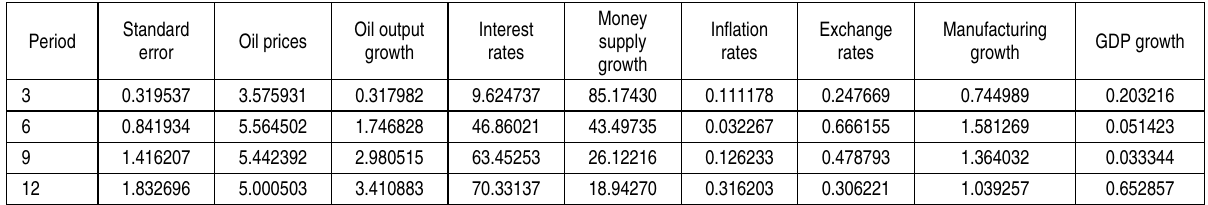
Table 2: Variance decomposition of money supply